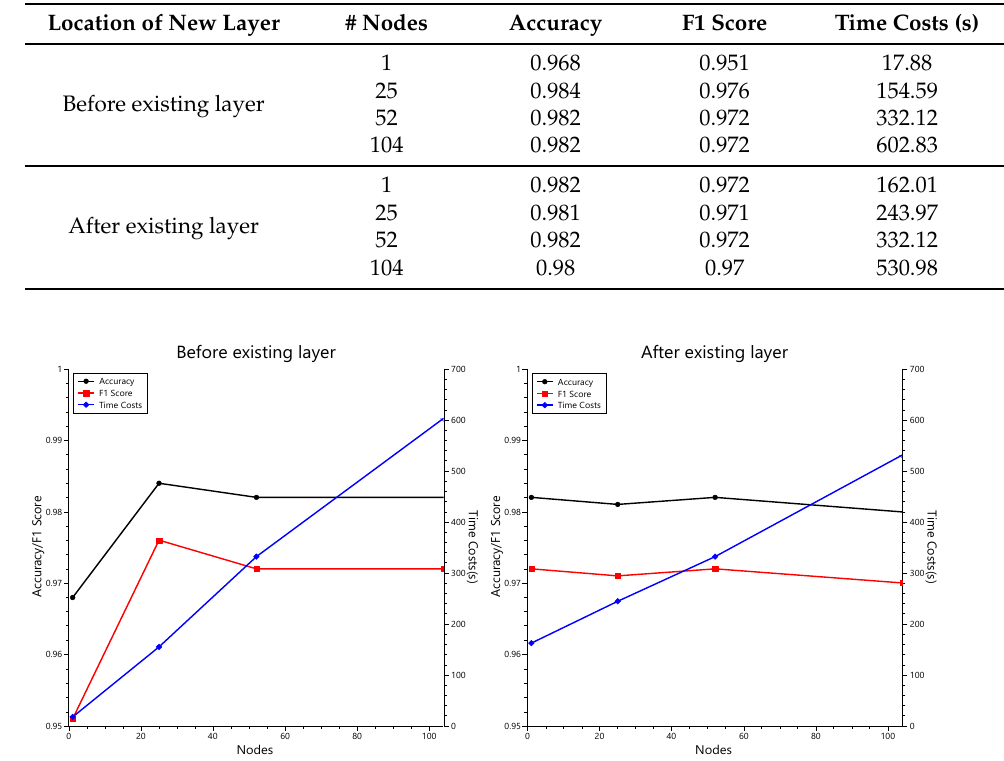
Figure 8. Schematization for the hyperparameter optimization result for double hidden